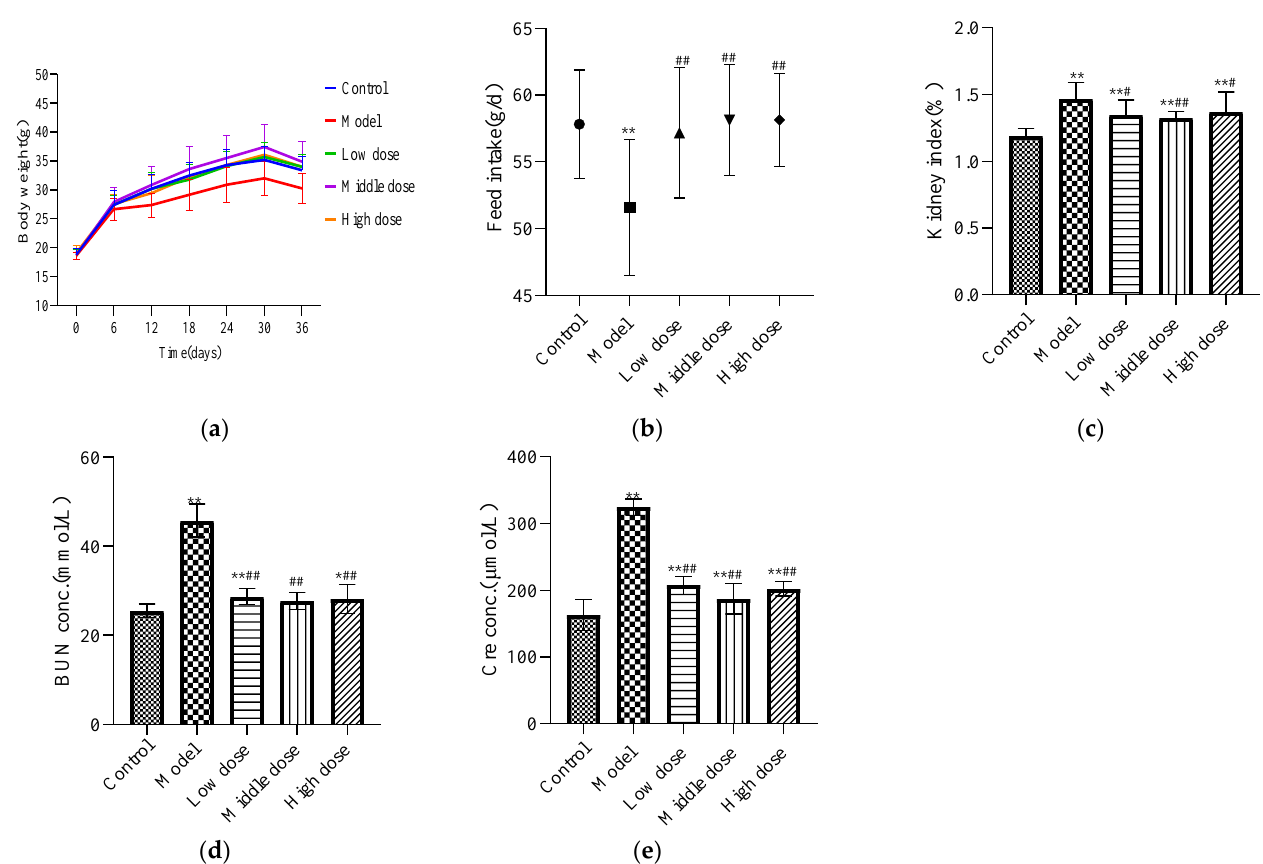
Figure 1. Pharmacodynamic evaluation index for LBP against lead-induced renal injury. The results are expressed as the mean ± SD. * Statistically significant compared to control group, * p < 0.05, ** p < 0.01. # Statistically significant compared to model group, # p < 0.05, ## p < 0.01. ( a ) Weight change of mice; ( b ) feed intake of mice; ( c ) renal index; ( d ) expression level of BUN; ( e ) expression level of Cre.